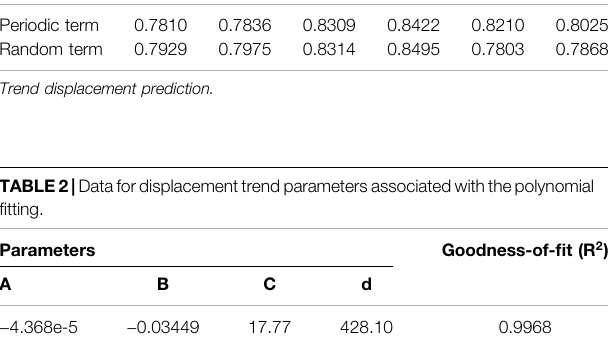
Figure 5 . The dotted lines in blue represent the low- frequency of each indicator, and these are characterized by steady cyclical variations. The eight peaks and troughs associated with the indicator curve for each in fl uencing factor correspond to the eight monitoring periods of the selected training dataset. Similarly, the dotted lines in red depict the high-frequency term of various indicators, and the curves exhibit irregular variation during the monitoring period. Therefore, the high-frequency term is suitable for predicting the random displacement, while the low-frequency term is useful for forecasting the periodic displacement. Based on GRA method, the grey correlation degree γ k between the periodic displacement, the random displacement, and the controlling factor decomposition terms were calculated and the results are presented in Table 1 . A γ k value > 0.6 between the displacement decomposition term and the decomposition term of a controlling factor indicates that they are closely related